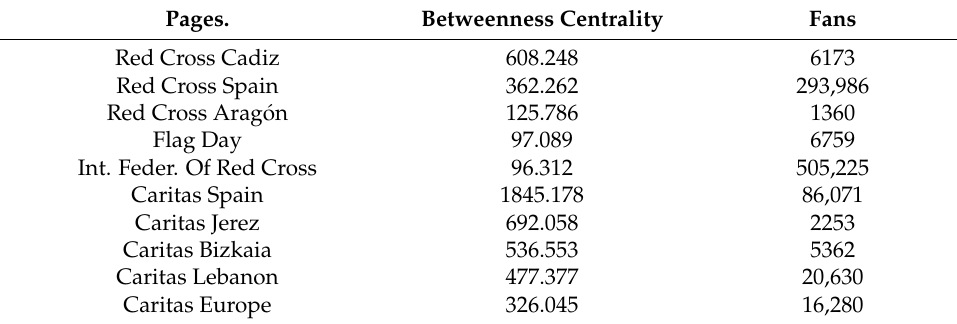
Table 5. Pages with the highest level of intermediation.